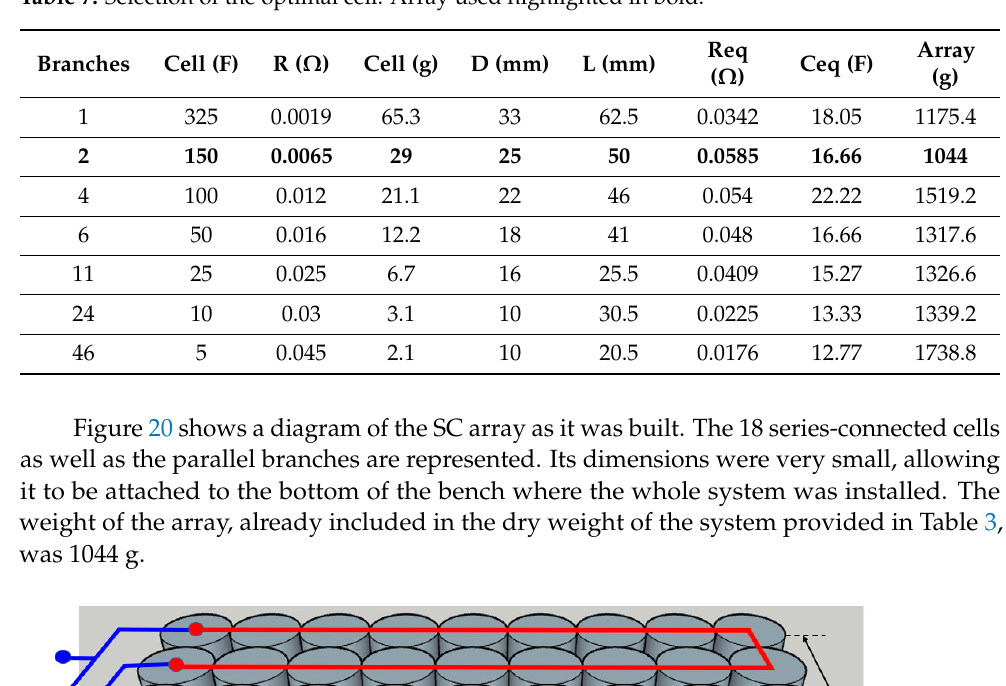
Table 7. Selection of the optimal cell. Array used highlighted in bold.